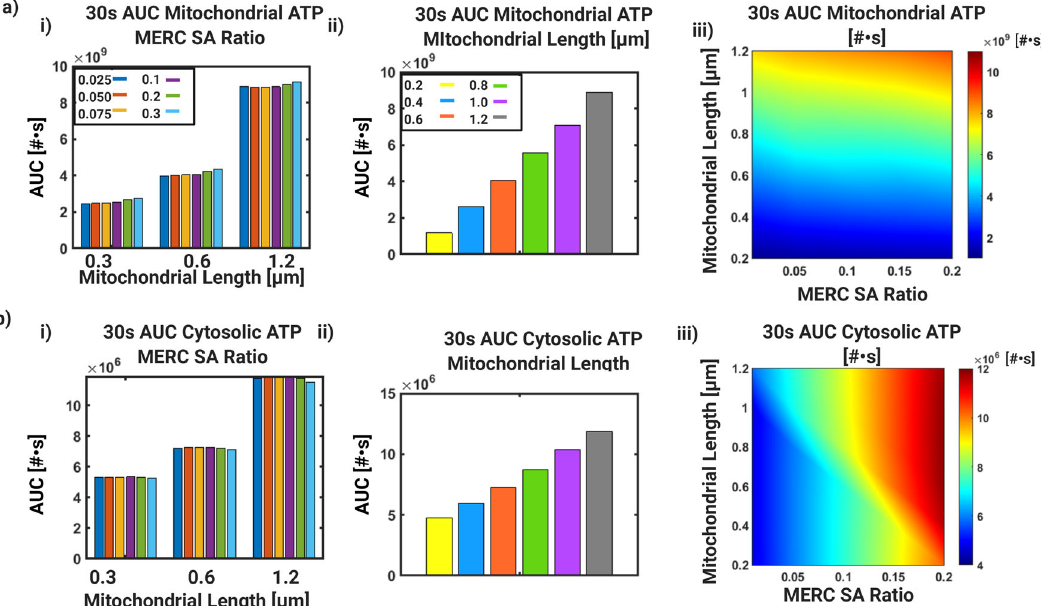
Fig. 6 Area Under the Curve (AUC) for varying mitochondrial length and MERC SA. For variations in both Figs. 4 and 5, we quantify the total metabolic output through the computation of AUC in terms of molecules of ATP for 30 s for the respective compartment volumes. a ) Mitochondrial ATPAUC quanti fi ed for a window of 30s starting from time of stimulus. i ) For 3 mitochondrial sizes, 0.3, 0.6, and 1.2 μ m, the AUC for increasing surface area ratios, 0.01, 0.05, 0.1, 0.2, 0.3 as shown in Fig. 5. ii ) The AUC for a fi xed SA ratio of 0.1 and increasing values of mitochondrial length, as shown in Fig. 4. iii ) Phase diagram of AUC shows combined effect of MERC SA ratio and mitochondrial length on mitochondrial ATP AUC at 30 s. For both Figs. 4 and 5, we quantify the total metabolic output through the computation of AUC in terms of molecules of ATP for 30 s for the respective compartment volumes. b ) Cytosolic ATPAUC quanti fi ed for a window of 30s starting from time of stimulus. i ) For 3 mitochondrial sizes, 0.3, 0.6, and 1.2 μ m, the AUC for increasing surface area ratios, 0.01, 0.05, 0.1, 0.2, 0.3, as shown in Fig. 5. ii ) The AUC for a fi xed SA ratio of 0.1 and increasing values of mitochondria, as shown in Fig. 4. iii ) Phase diagram of AUC shows combined effect of MERC SA ratio and mitochondrial length on cytosolic ATP AUC at 30